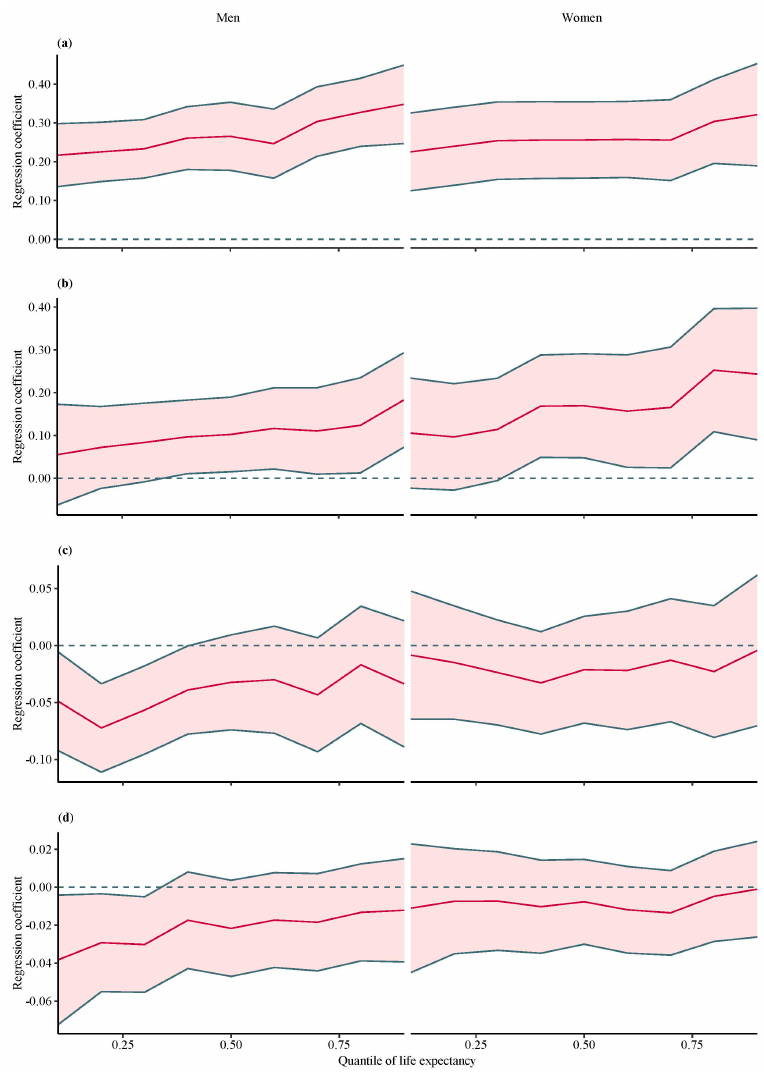
Figure 1. Quantile regression coefficients for life expectancy and macroeconomic factors on percentiles of total life expectancy in 65 Belt and Road countries. This picture shows the quantile regression coefficients (red line) with their 95% CI for the relationship between life expectancy and macroeconomic factors. ( a ) Quantile regression coefficients for GDP per capita and life expectancy on percentiles of total life expectancy; ( b ) Quantile regression coefficients for unemployment rate and life expectancy on percentiles of total life expectancy; ( c ) Quantile regression coefficients for GDP growth rate and life expectancy on percentiles of total life expectancy; ( d ) Quantile regression coefficients for inflation and life expectancy on percentiles of total life expectancy.